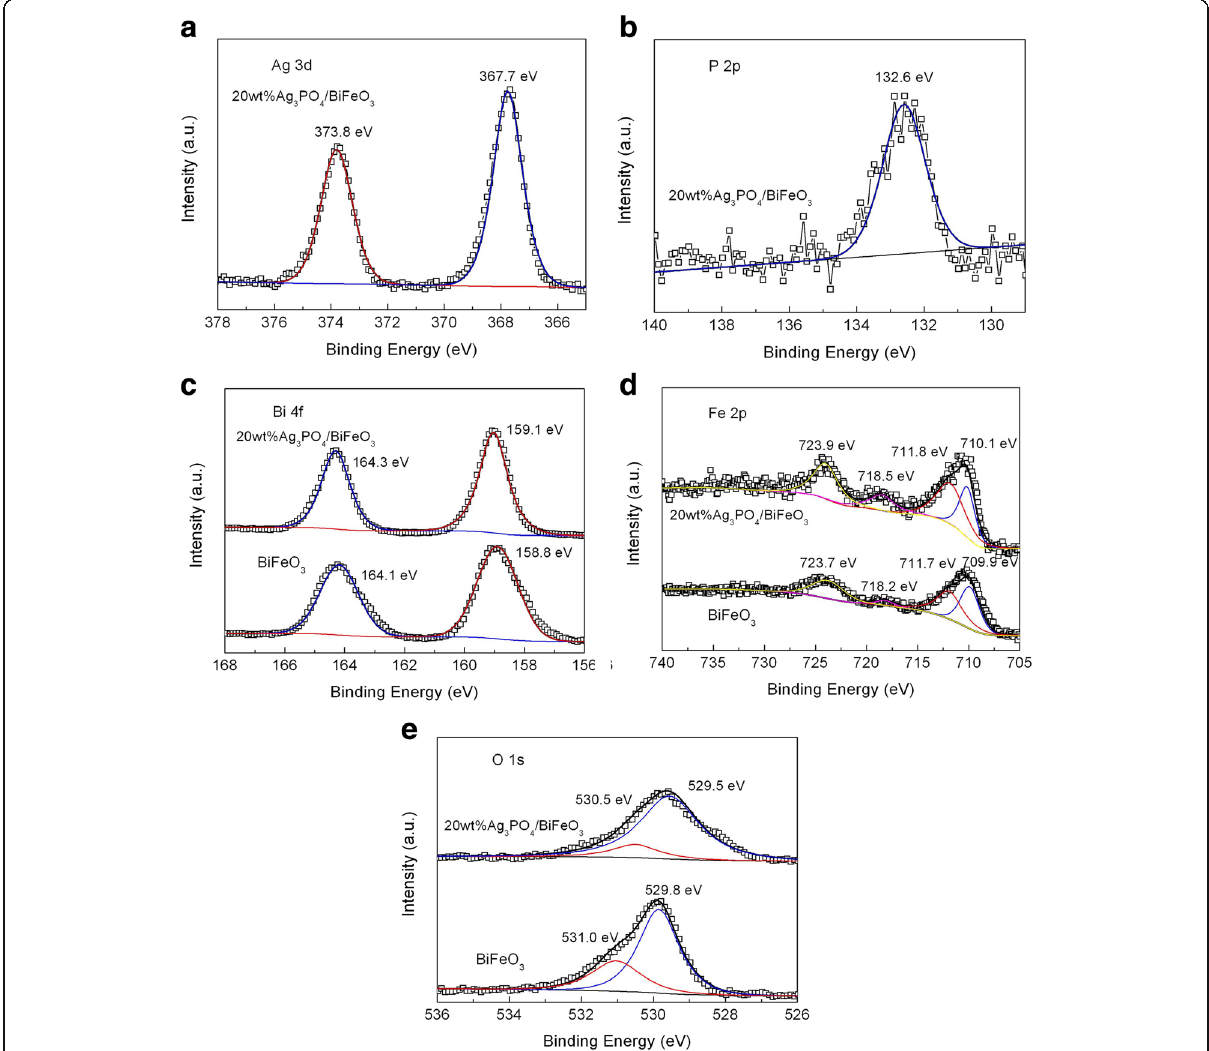
Fig. 3 High-resolution XPS spectra of BiFeO 3 and 20wt%Ag 3 PO 4 /BiFeO 3 sample. a Ag 3d and b P 2p of 20wt%Ag 3 PO 4 /BiFeO 3 sample. c Bi 4f, d Fe 2p, and e O1s of BiFeO 3 and 20wt%Ag 3 PO 4 /BiFeO 3